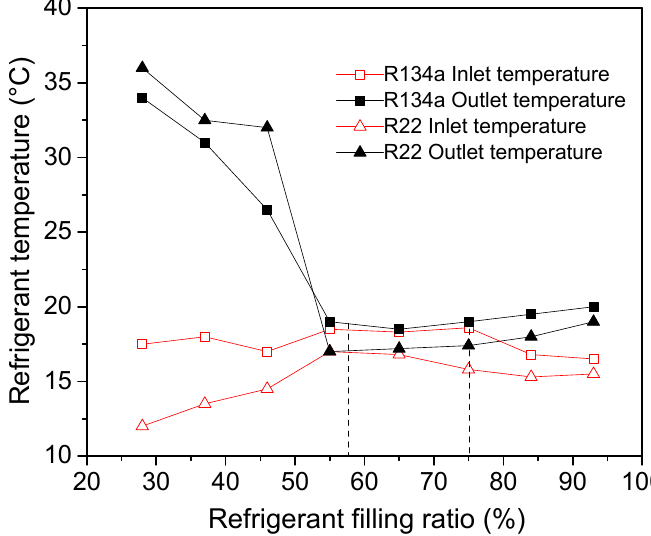
Figure 9. Temperature of refrigerant inlet and outlet in evaporator.